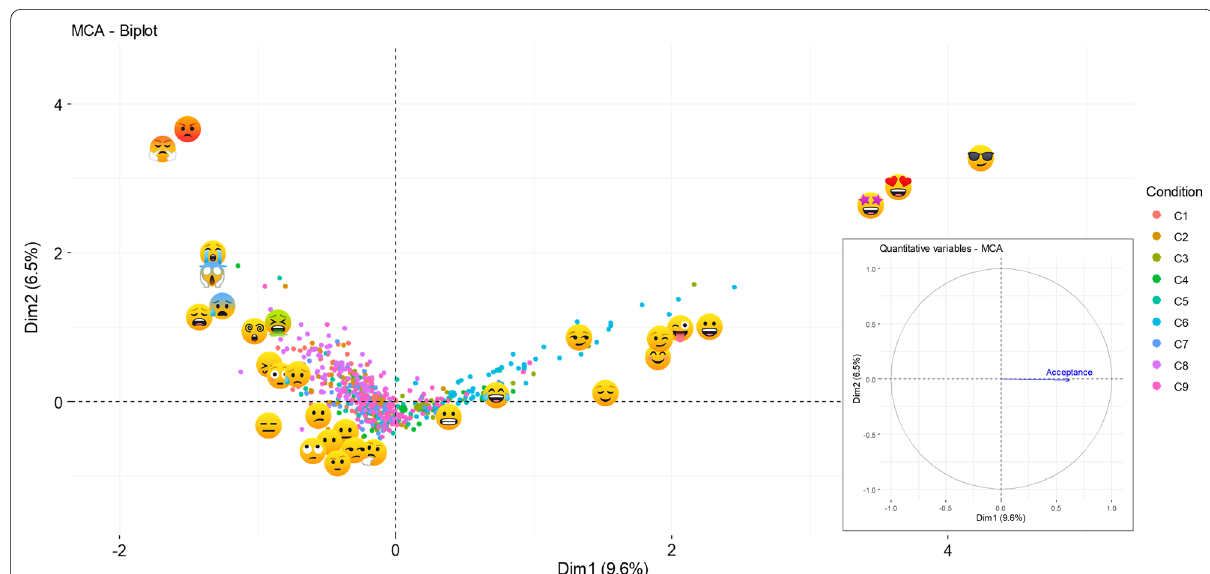
Fig. 4 Multiple correspondence analysis factor map. C1—crowding, C2—anterior open bite, C3—interincisal diastema, C4—increased overjet and deep bite (Class II division 1), C5—anterior crossbite (Class III), C6—ideal occlusion, C7—unilateral posterior crossbite, C8—anterior open bite plus bilateral posterior crossbite plus crowding, and C9—deep bite (Class II division